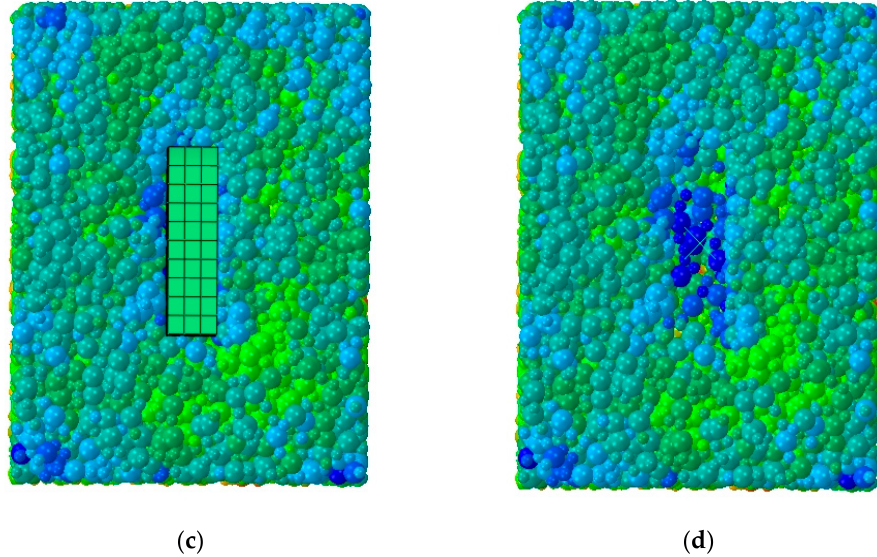
Figure 9. DEM–FEM simulation of the drop tests: ( a ) dropping the weight; ( b ) penetration after collision; ( c ) weight stopped; ( d ) interrupted gravel layer due to penetration.